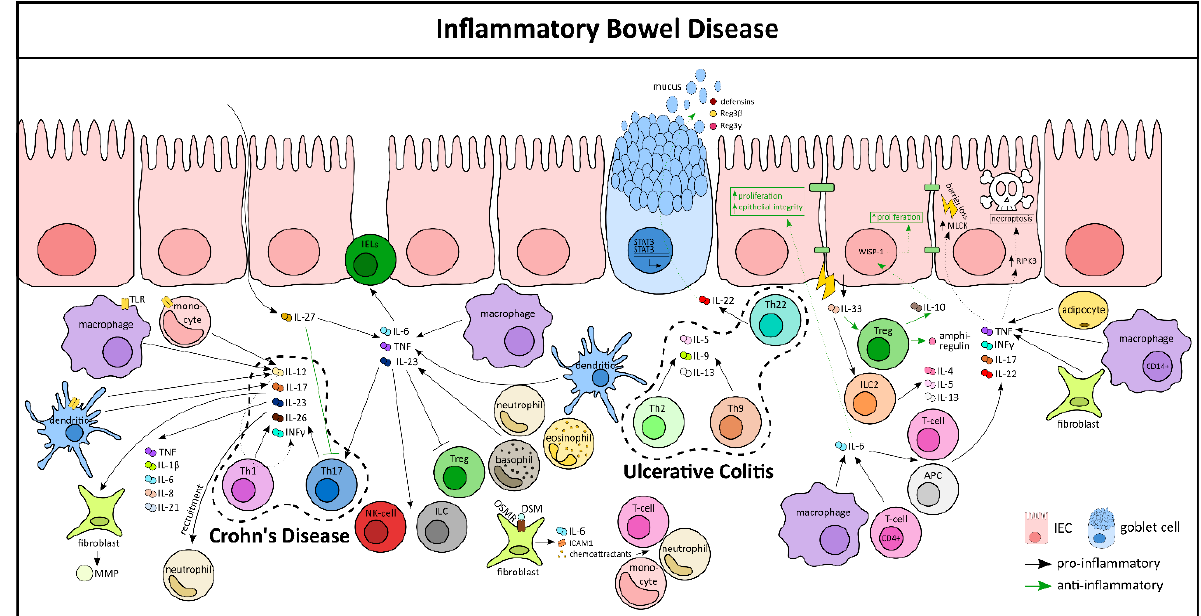
Figure 3. Cytokine-mediated immune–epithelial crosstalk in inflammatory bowel diseases. APC, antigen-presenting cell; ICAM, intercellular adhesion molecule-1; MLCK, myosin light chain kinase; MMP, matrix metalloproteinase; OSM, Oncostatin M; OSMR, Oncostatin M receptor; RIPK3, receptor interacting serine/threonine kinase 3; WISP-1, WNT 1-inducible signaling pathway protein 1.